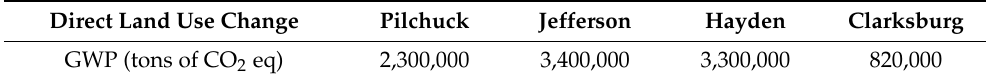
Table 11. Direct Land Use Change